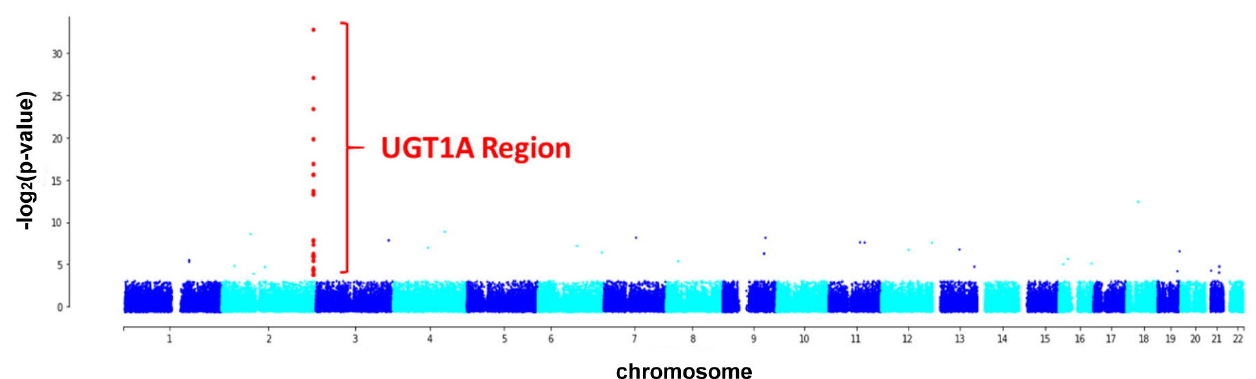
Figure 1. Manhattan plot visualizing the p -values of the allele frequency changes among the subjects with Gilbert’s syndrome (test group) and healthy individuals (control group). Most of the significant single nucleotide polymorphisms (SNPs) are located in the UGT1A region (chr2:233617645– 233773305).